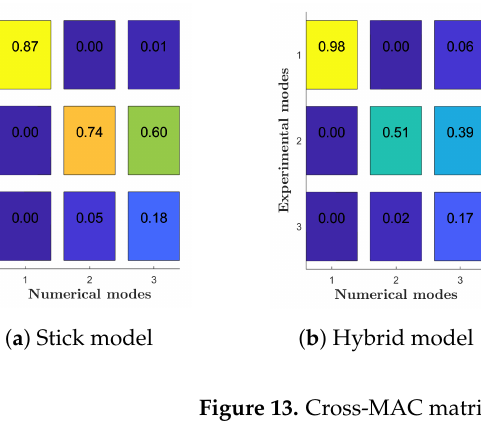
Figure 13. Cross-MAC matrices of the mass-backward